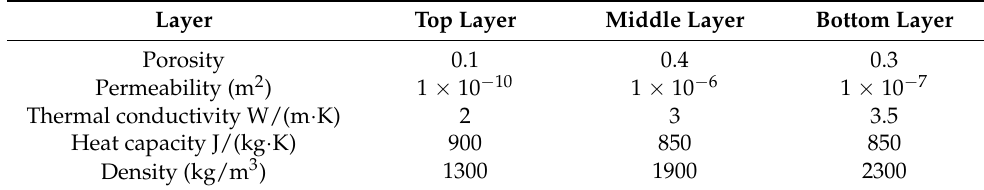
Table 2. Three layers of GPG in